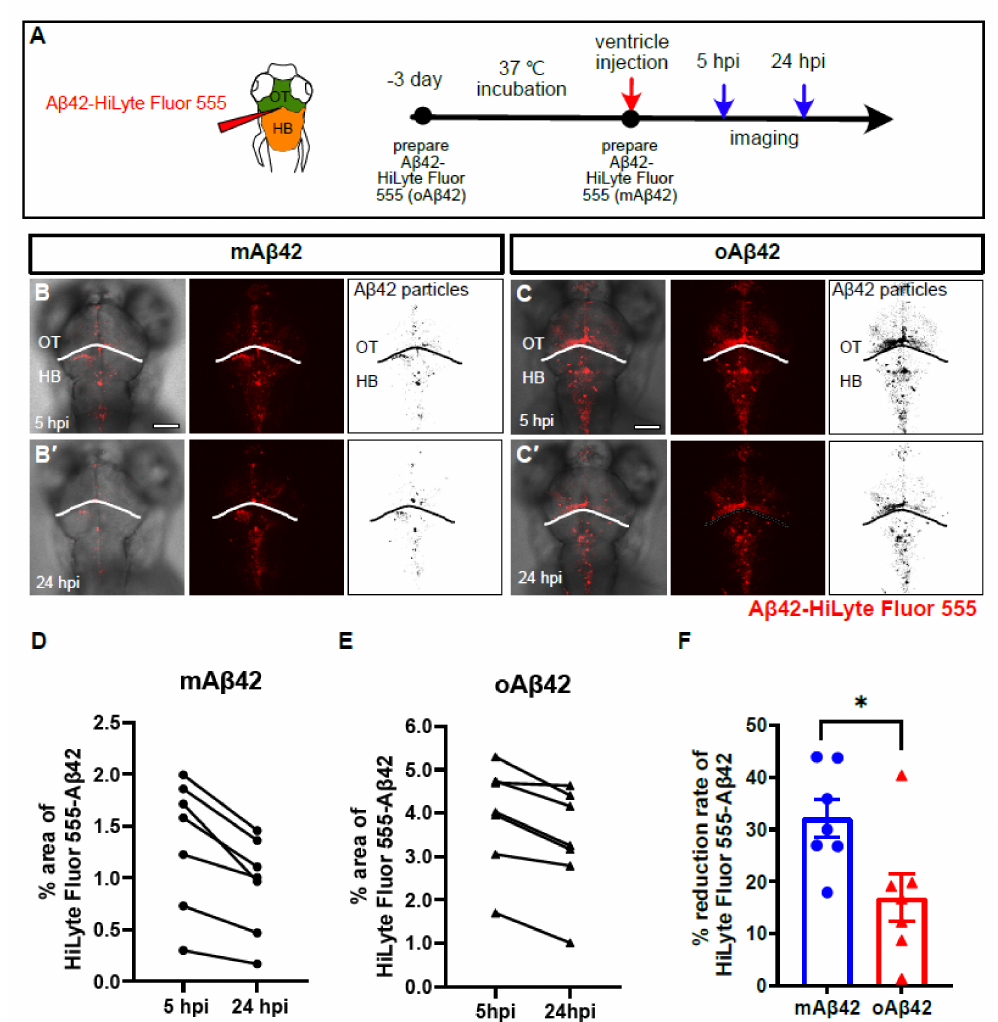
Figure 1. Monomeric A β 42 peptides are more efficiently cleared from the brain than oligomeric A β 42. ( A ) A schematic diagram of experimental setup. Fluorescently labeled A β 42 prepared at different time points were injected into the brain followed by in vivo imaging at 5 hpi and 24 hpi. ( B , C (cid:48) ) Distribution of injected, fluorescently labeled A β 42 (mA β 42 or oA β 42) in the brains of 3 dpf larvae at 5 hpi ( B , C ) and 24 hpi ( B (cid:48) , C (cid:48) ) (left, overlays with brightfield; middle, HiLyte Fluor 555; right, thresholded images of A β 42 fluorescence). ( D , E ) Quantification of the area fraction (%) occupied by A β 42 fluorescence within square unit (512 × 512 pixels) at different time points. ( F ) Clearance rate of mA β 42 and oA β 42 between 5 hpi and 24 hpi by fluorescence quantification. Two-tailed unpaired t -test, p = 0.023. Data are presented as mean ± SEM. N = 7 per group. Data are representative of at least three independent experiments. dpf, days post fertilization; hpi, hours post injection; HB, hindbrain; OT, optic tectum, Scale bars = 100 µ m. * p <